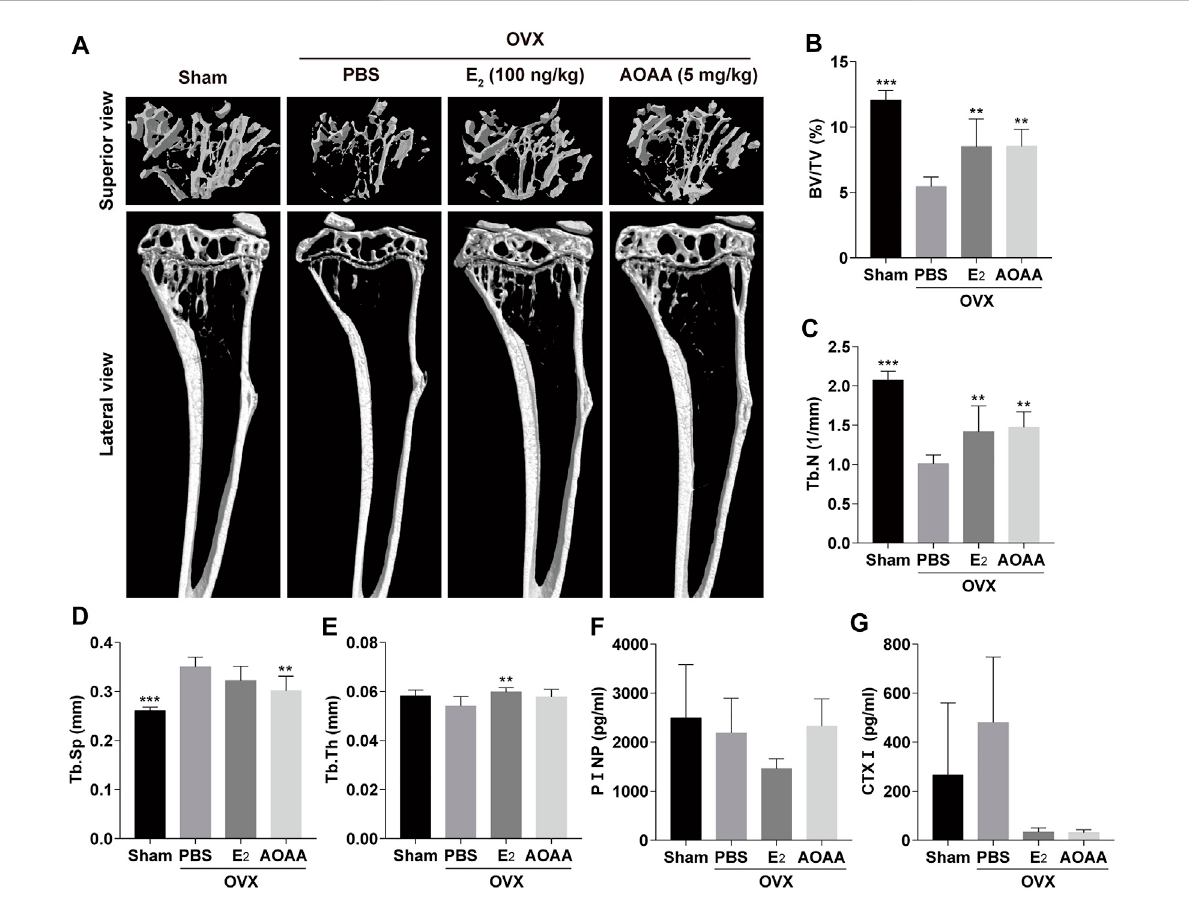
FIGURE 6 AOAA treatment prevents OVX-induced bone loss in vivo . (A) Representative micro-CT images of the tibia structures in each group. (B – E) Quanti fi cationoftheparametersregardingthebonemicrostructure(includingBV/TV,Tb.N,Tb.Sp,andTb.Th)ineachgroup( n =6). (F,G) Therelative levels of serum P Ⅰ NP and CTX Ⅰ were detected using the enzyme-linked immunosorbent assay kits ( n = 3). All experimental data are expressed as mean ± SD. **p < 0.01, ***p < 0.001 compared with that in the PBS group. One-way ANOVA was